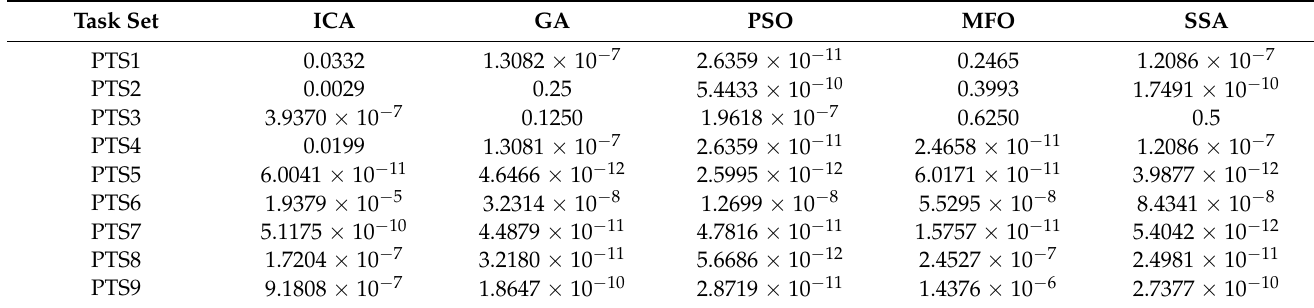
Table 11. The Wilcoxon rank sum test p